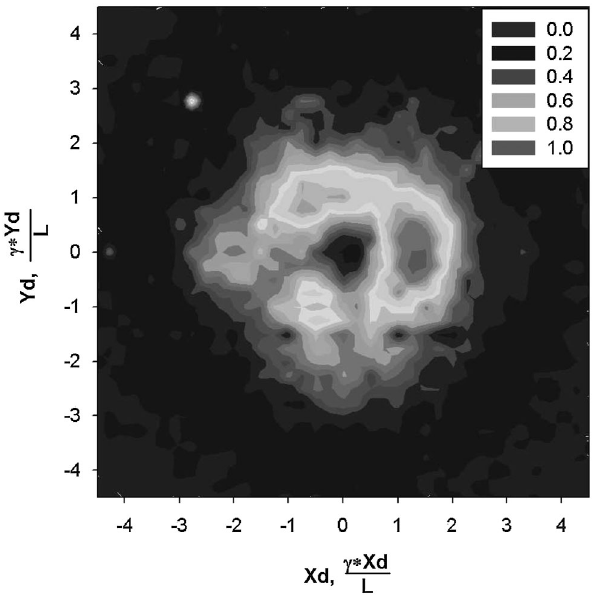
FIG. 9. Both polarization components of OTR spatial distribu- tion for a 609 (cid:7) 28 nm filter from a spherical target.